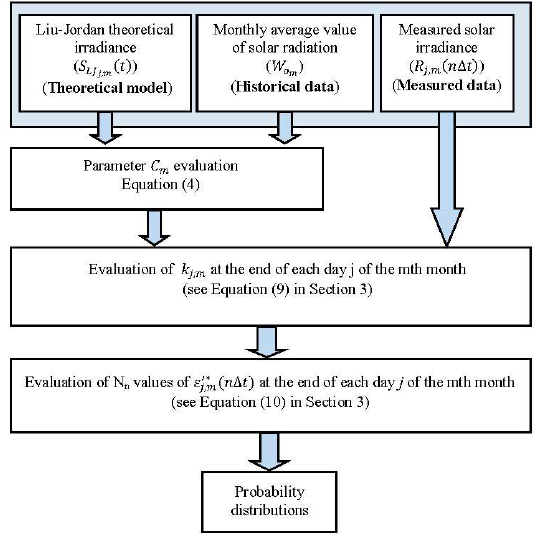
Figure 2. Flow chart of the “Statistical Analysis” stage.